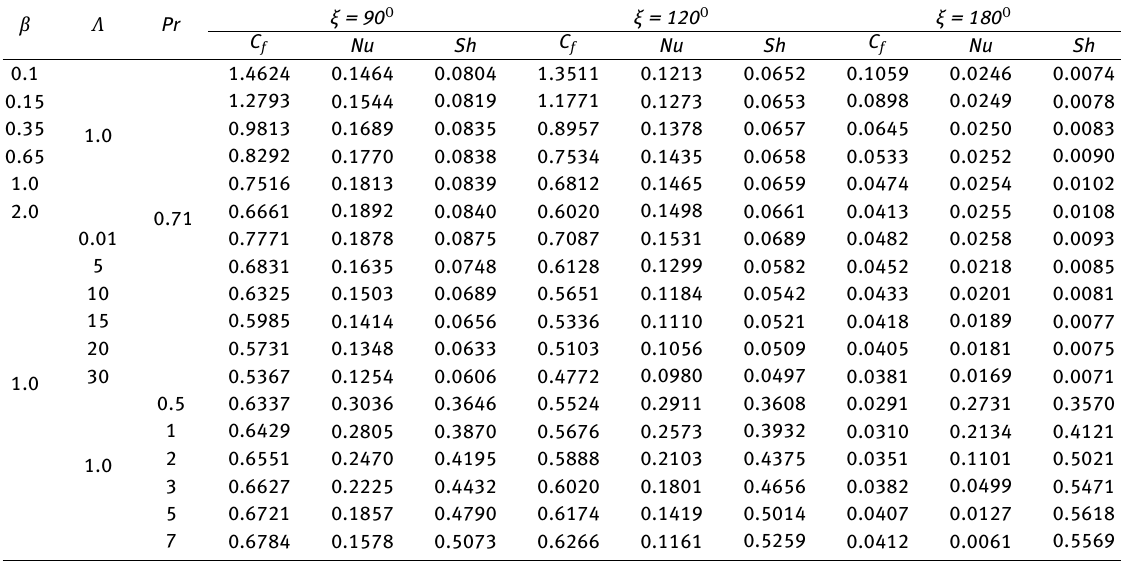
Table 3: Values of C f , Nu and Sh for various values of β , Pr, Sc and ξ ( Nb = Nt = 0.2, Nr = 0.1, Da = 1.0, M = 0.5, Le = 0.6)